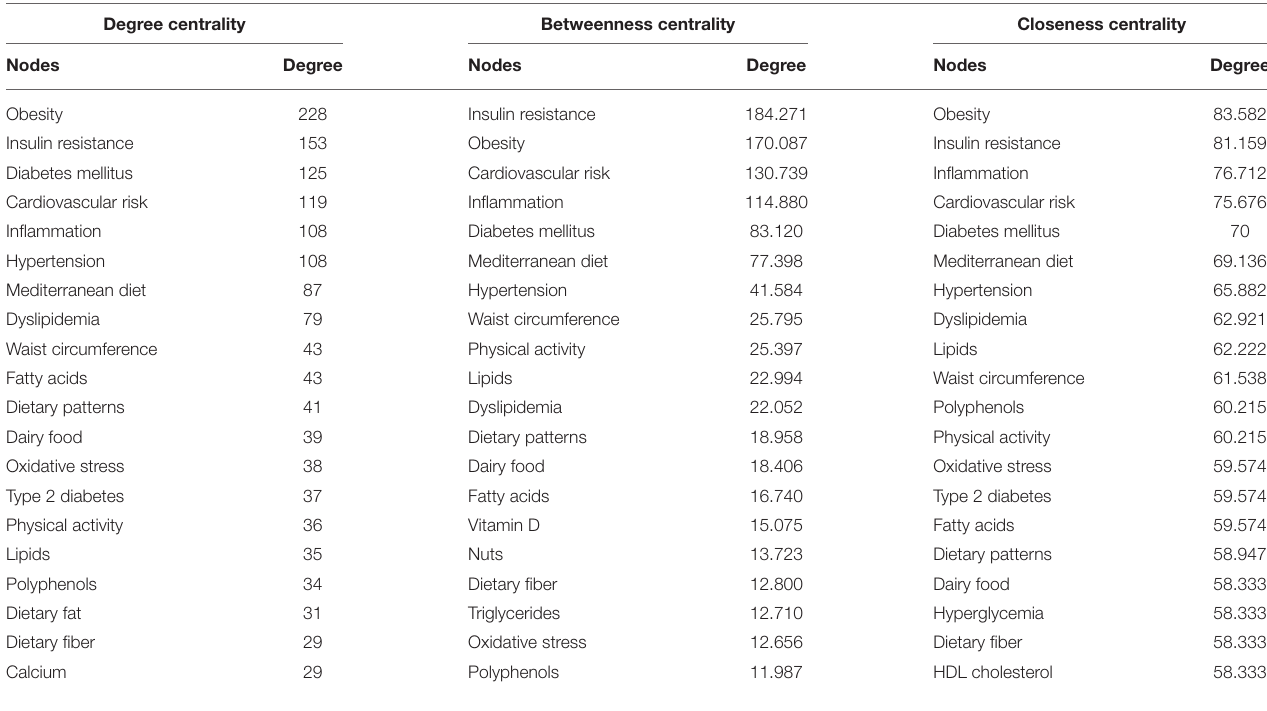
TABLE 1 | Top 20 nodes of highly frequent keywords